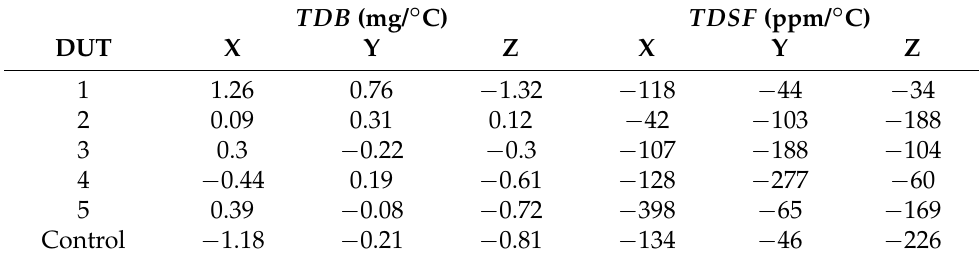
Figure 11. TDB and TDSF computing from the TD X values (DUT #1, Z axis). 0 The TDB sign and values appears to be random, with values up to 1.3 mg/ ◦ C. DUT #1 has the largest temperature drifts, with 1.3 mg/ ◦ C in two axes. DUTs #2 to #5 show lower temperature drifts, with typical values around 0.4 mg/ ◦ C. The control DUT also shows large temperature drifts, up to 1 mg/ ◦ C. All computed TDSF are negative in sign but random in value. The Z axes do not show greater temperature drifts compared to the X axes. The Y axis has lower drifts than the others. The parameters obtained for each axis are shown in Table 5. Table 5. Computed temperature drifts parameters for each axis and